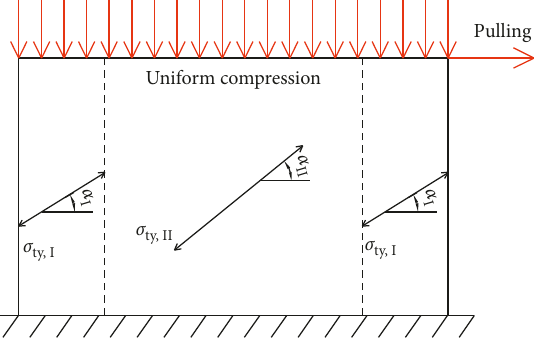
Figure 11: Yield stress of the infill steel plate under compression and shear.